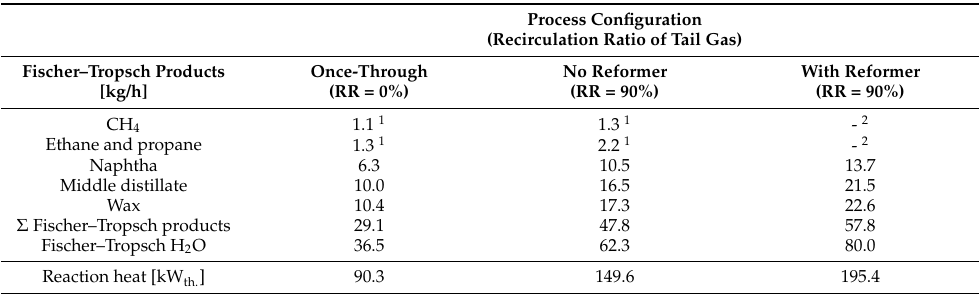
Table 4. Fischer–Tropsch products and reaction heat for various process